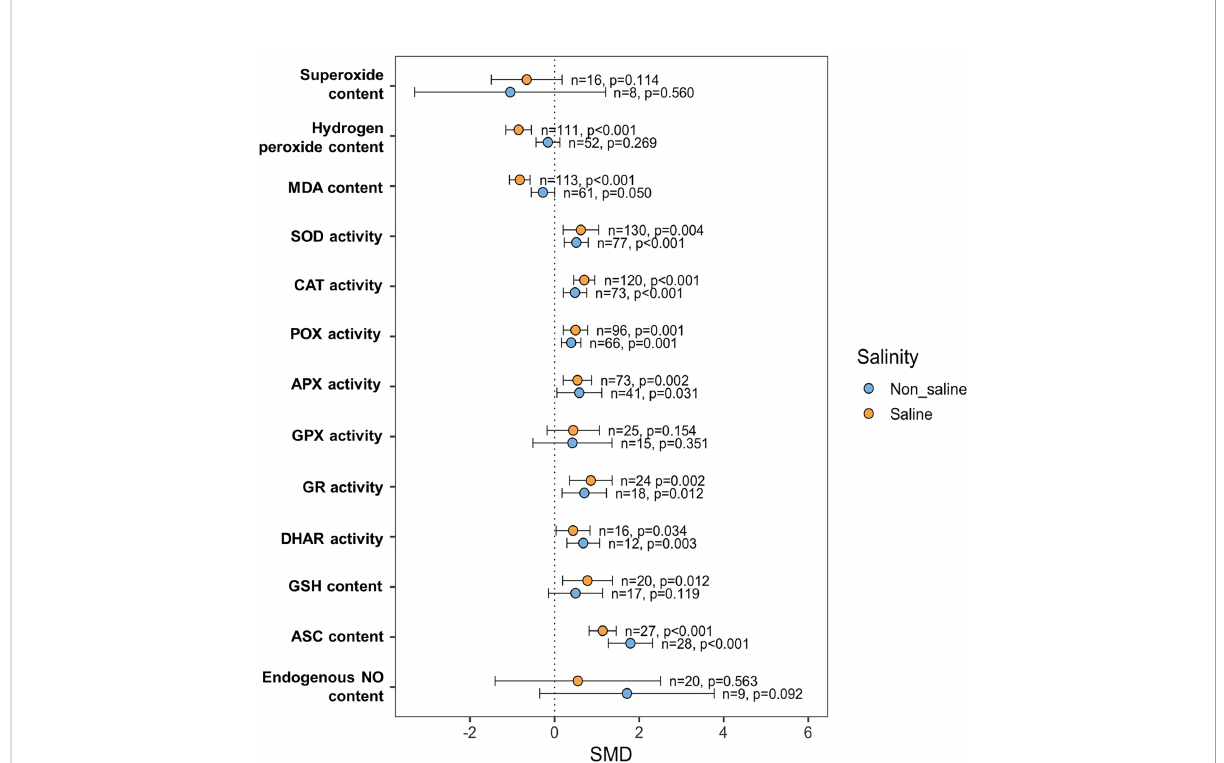
FIGURE 8 Exogenous NO effects on ROS scavenging and antioxidant capacity such as superoxide, hydrogen peroxide (H 2 O 2 ), malondialdehyde (MDA), superoxide dismutase (SOD), catalase (CAT), peroxidase (POX), ascorbate peroxidase (APX), glutathione peroxidase (GPX), glutathione reductase (GR), dehydroascorbate reductase (DHAR), glutathione (GSH), ascorbate (ASC) and endogenous NO content in salt-induced plants. The error bars are the effect size means ±95% CIs. Where the CIs do not overlap the vertical dashed lines, the effect size for a parameter is signi fi cant, i.e., the growth responses of NO-treated plants were signi fi cantly different from those of non-NO-treated plants. n , the number of studies included in the meta-analysis; p , the signi fi cance level of